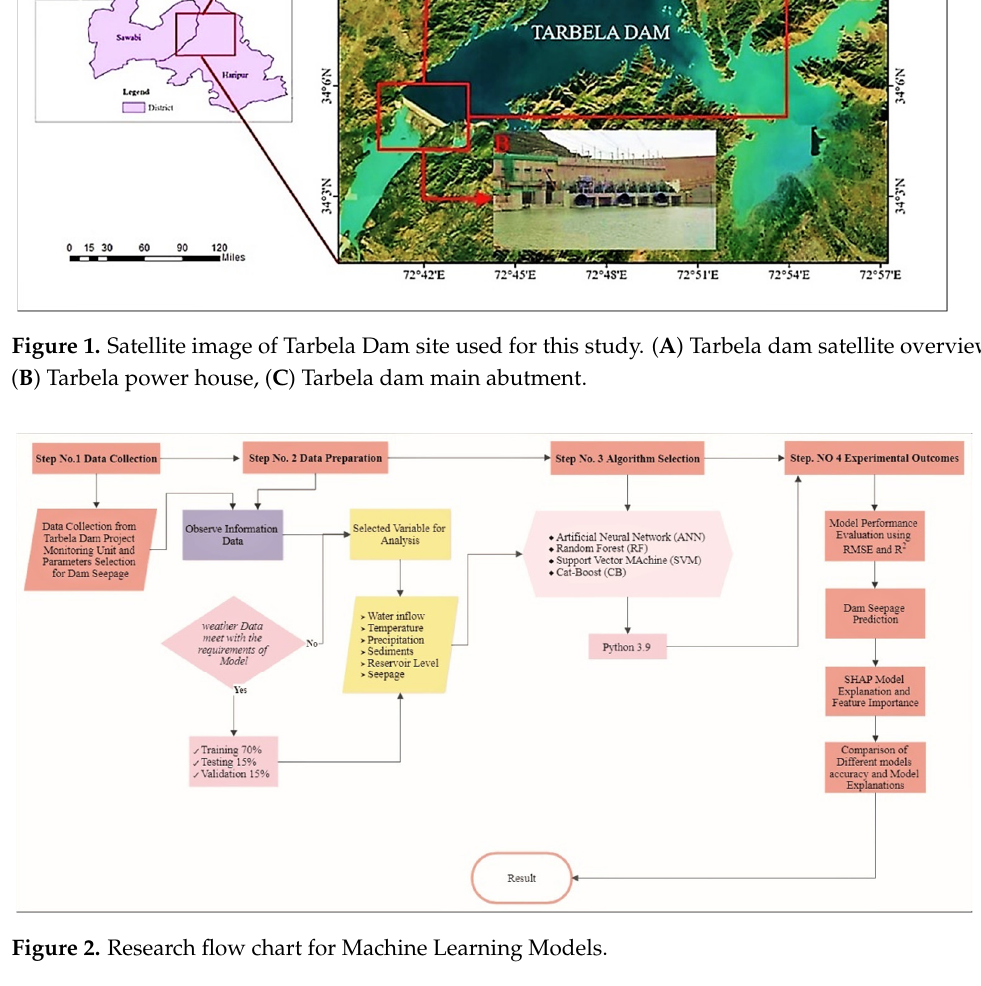
Figure 1. Satellite image of Tarbela Dam site used for this study. ( A ) Tarbela dam satellite over- view, ( B ) Tarbela power house, ( C ) Tarbela dam main abutment.